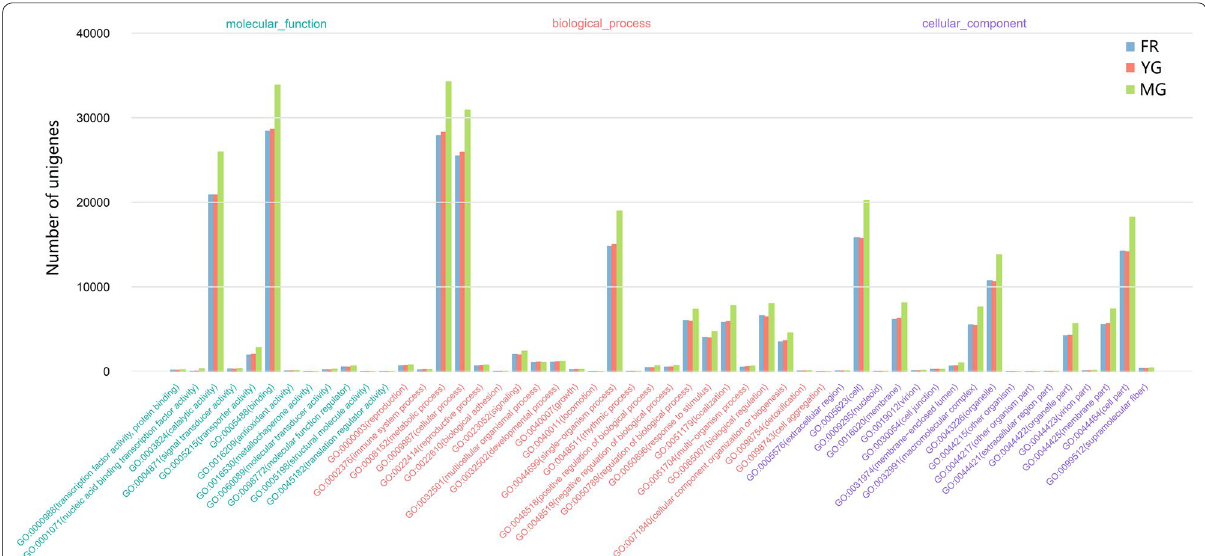
Fig. 1 Histogram of gene ontology (GO) annotations for unigenes in ginger matured rhizome, young rhizome, and fibrous root libraries. Level two GO terms belonging to three categories, molecular function, biological process, and cellular component are along the x-axis and the number of unigenes assigned to each term is represented along the y-axis. Bars with different colors indicate different